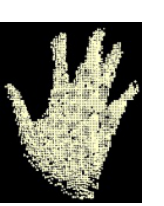
Figure 11. Example of rotation removal of a hand segment.